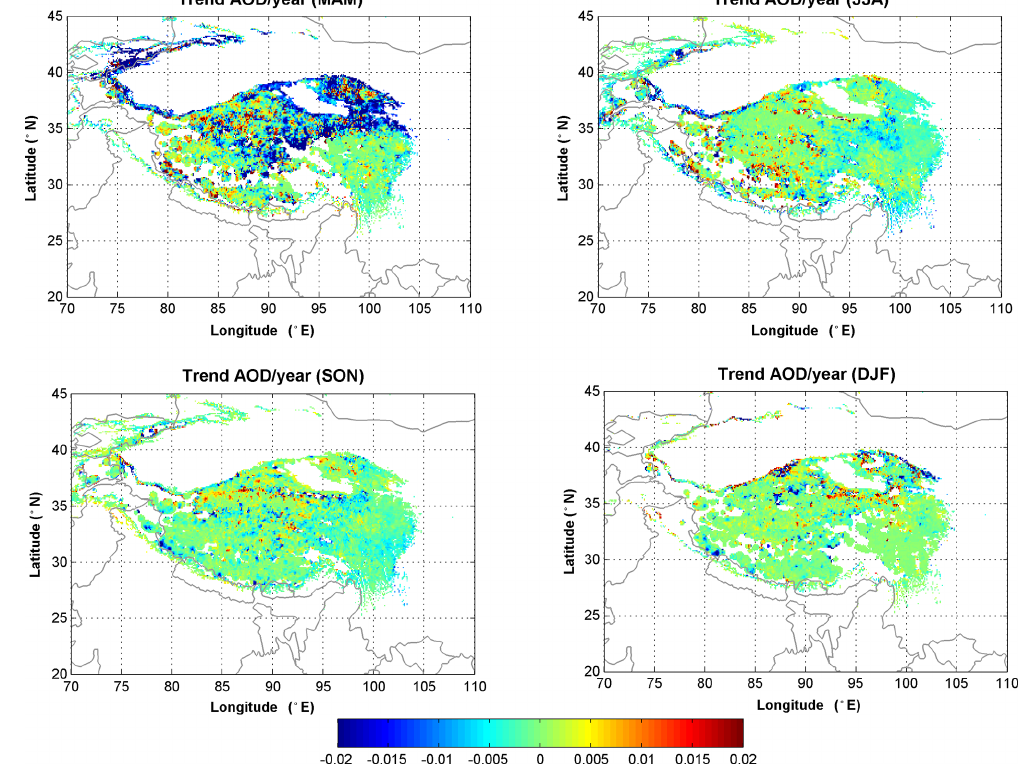
Figure 9. Trends in the MODIS_AOD at 550nm during 2006–2017 in each season.